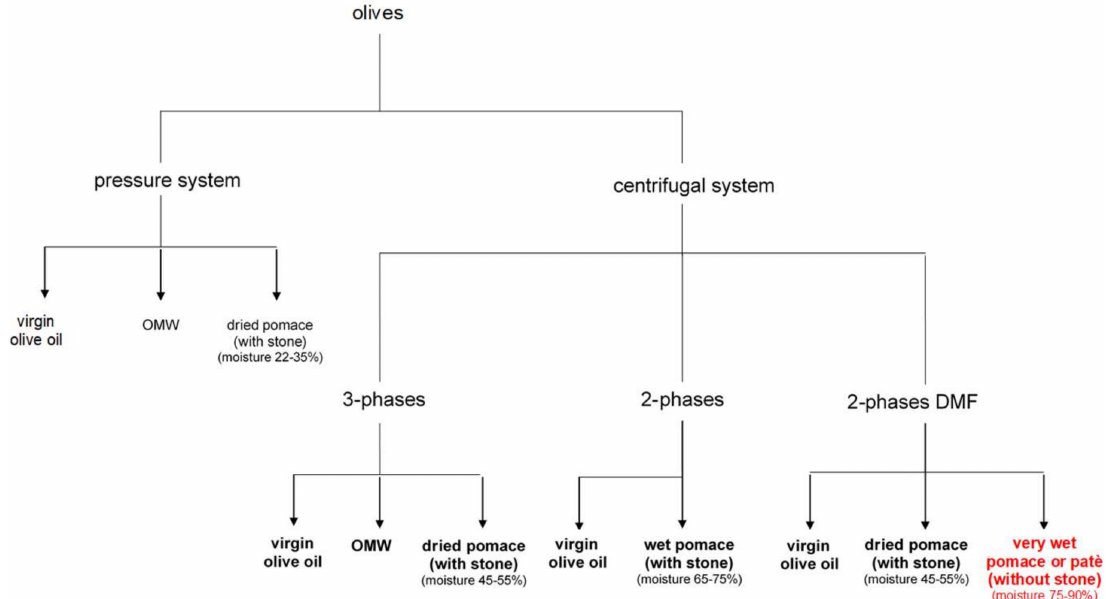
Figure 1. Scheme of olive pomace production. OMW = olive mill